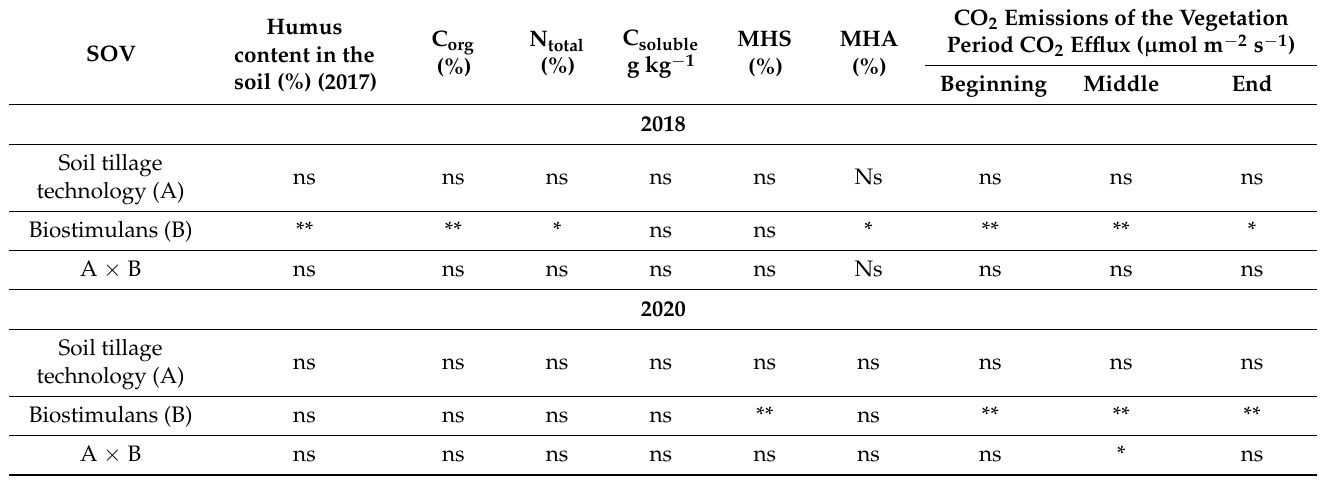
Table 3. Analysis of variance of soil tillage technology (A) biostimulants and their mixtures (B). SOV means sources of variation, MHS mobile humic substances, and MHA mobile humic